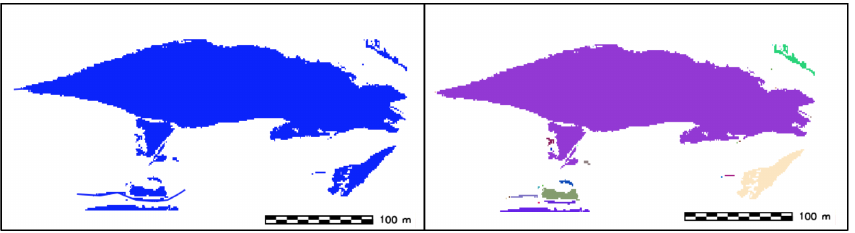
Figure 15. SW clumping.